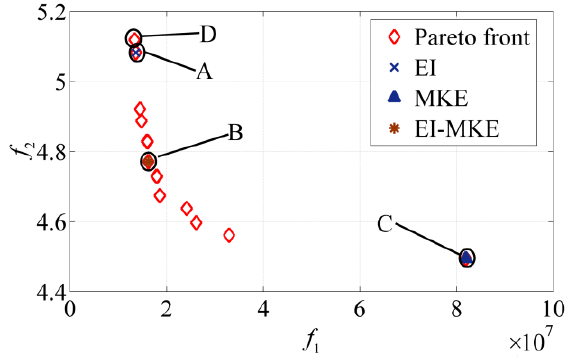
Figure 8. Optimal solutions of sensor placement based on the criteria of EI and MSMKE.